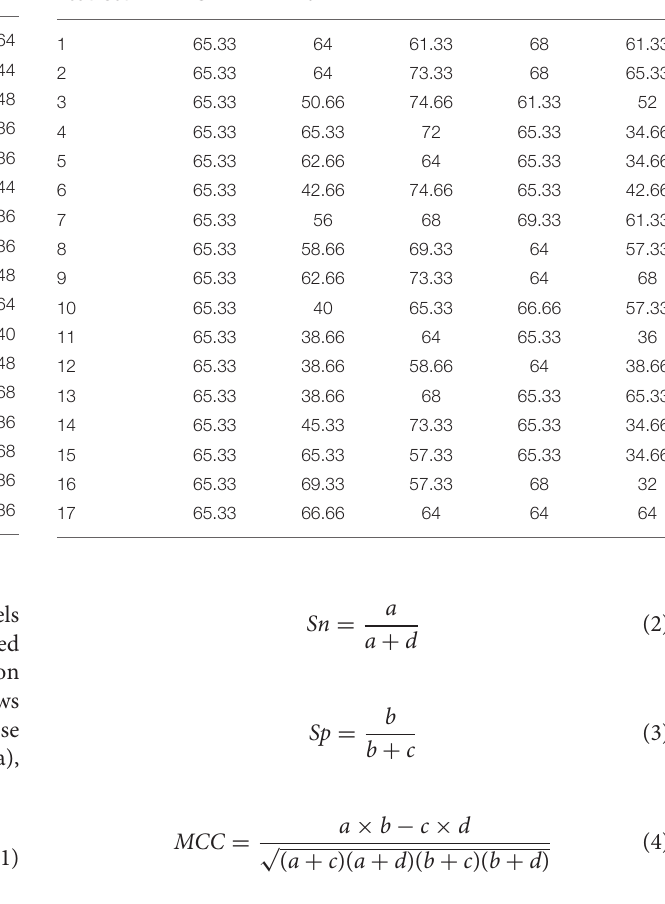
TABLE 3 | Performance of different models at different extracted features for voiced (V) modality obtained from SP channel. Feat. set